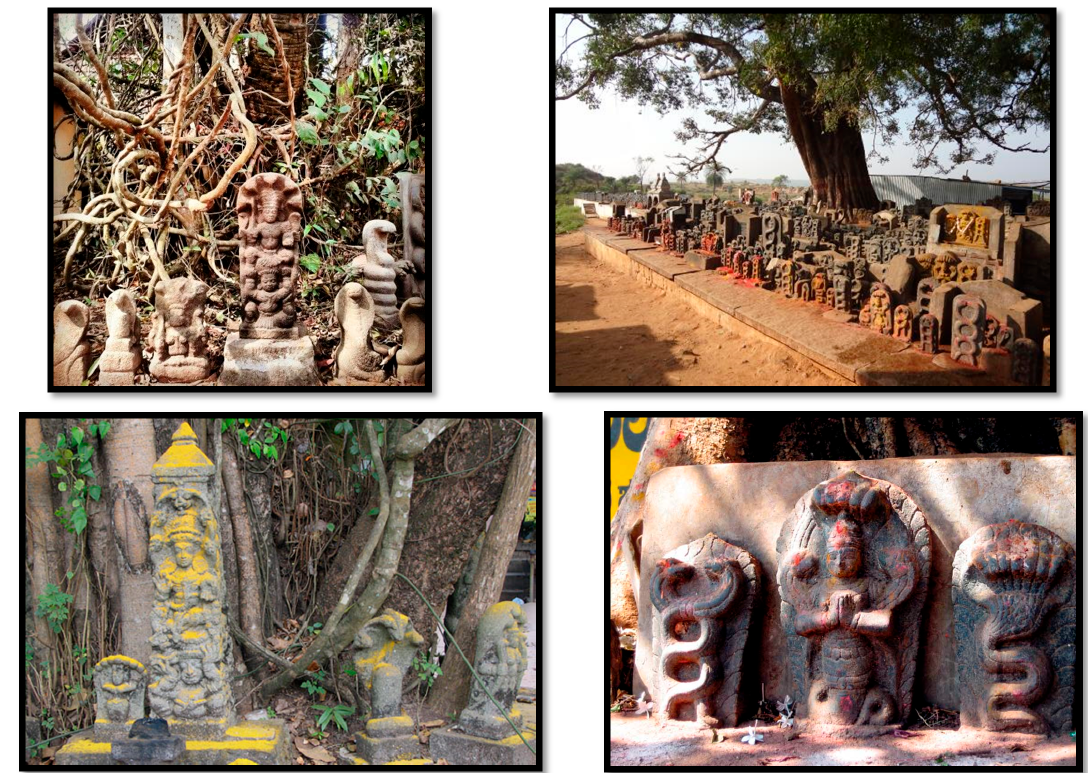
Figure 17. Naga Stones, Mannarasala ´Sri Nagaraja Temple, Kerala. N¯aga or nagini sculptures were salient as protectors of the entrance to the temple and its sanctum ( dv¯arap¯alak¯as ) (Figures 18–20).